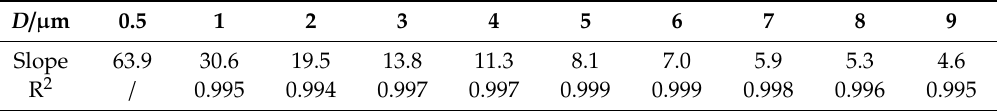
Figure 2. The calculated ripple position with the ripple number for the different sized quartz particles. Table 1. The slopes and the correlation coefficients of the linear fittings between the ripple width and particle size in Figure 2.